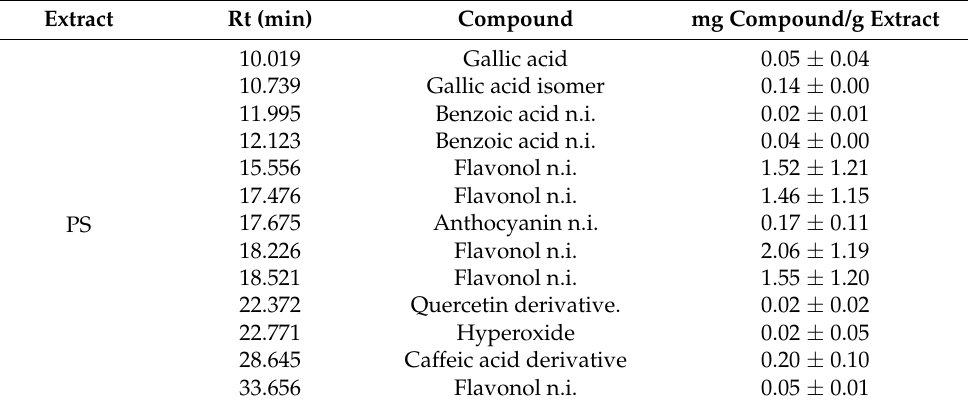
Table 3. Quantification of total phenolic compounds by HPLC-PAD in PS supercritical extract from the pulp and skin of